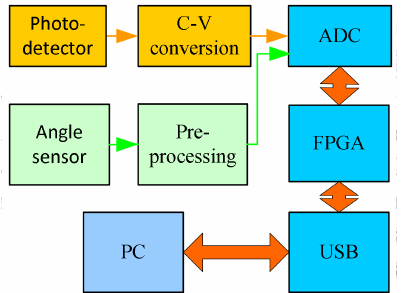
Figure 4. Structure of the signal detecting